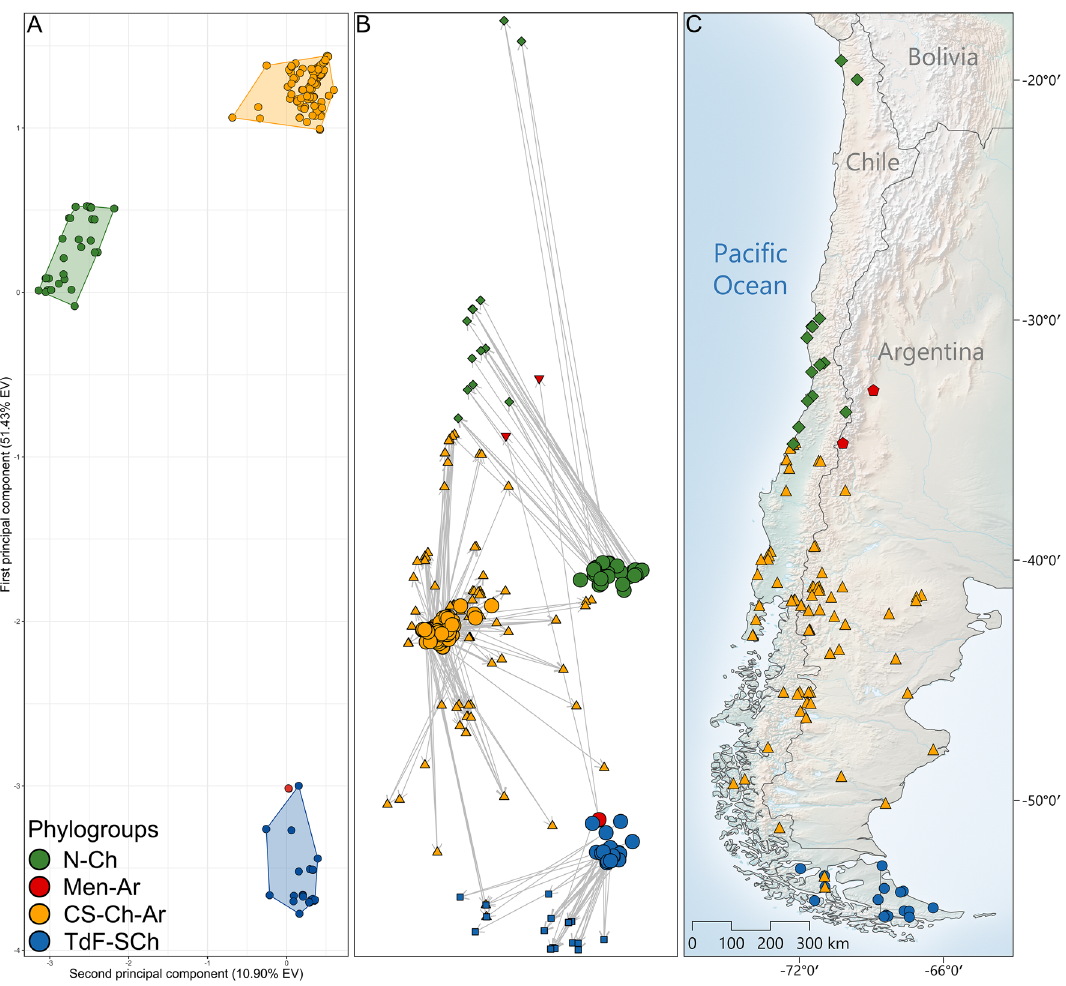
Figure 1. Procrustes analysis of the gPCA of Abrothrix olivacea and the 103 localities where individuals were captured. ( A ) Genetic map constructed from the projection of the individuals onto the orthogonal intersection of the two first principal components of the gPCA (SM, Fig. S3). ( B ) Procrustes superimposition of the transformed maps showing the position of individuals on the genetic map (larger circles) and on the geographic map (green diamonds = N-Ch, yellow triangles = CS-Ch-Ar, red inverted triangles = Men-Ar, and blue squares = TdF-SCg). The length of the line connecting individuals in gPCA map to their geographical location represents the extent of the deviation from the expected pattern of genetic variation based on geography (see Knowles et al. 77 ). ( C ) Geographic map constructed from geographical coordinates of the localities where the individuals were sampled; this plate was composed using QGIS, version 3.18.2-Zürich. Localities are colored according to colors gave to the mitochondrial phylogroups.